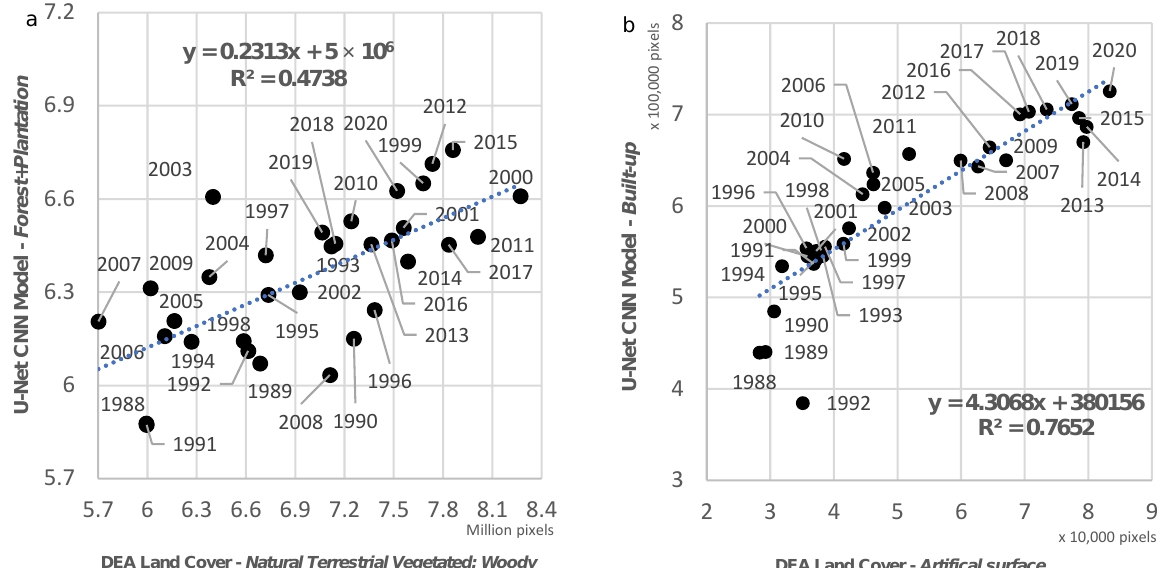
Figure 9. Relationship between DEA Land Cover and U-Net CNN model for Natural Terrestrial Vegetation: Woody vs. Forest + Plantation ( a ) and Artificial Surface vs. Built-up ( b ). Other classes are less well correlated.